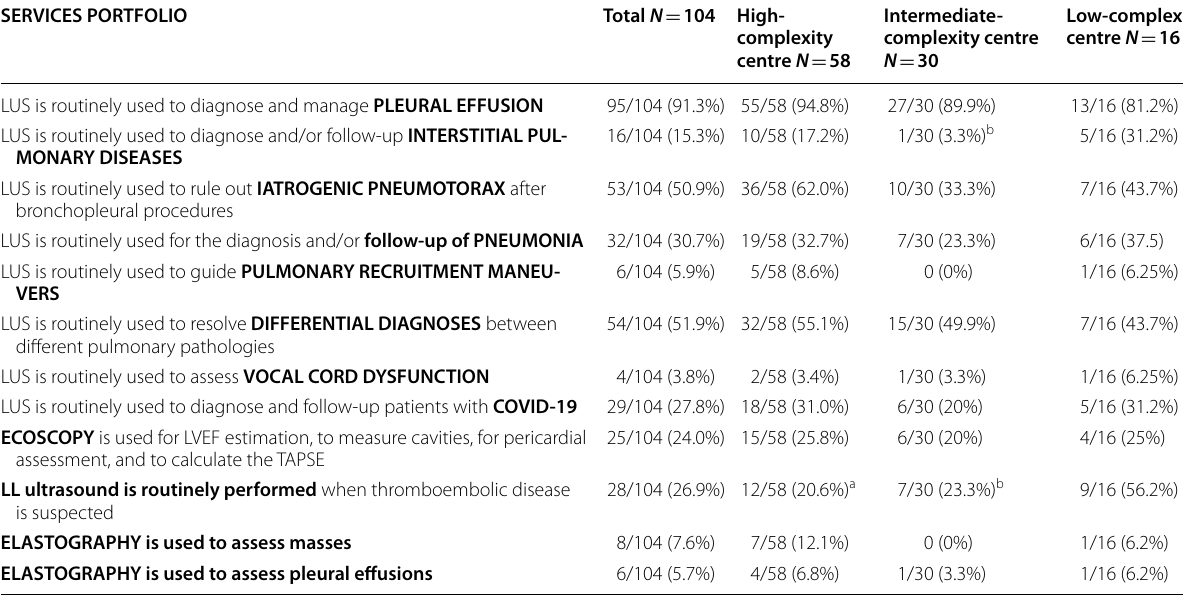
Table 2 Factors related to the portfolio of ultrasound services available